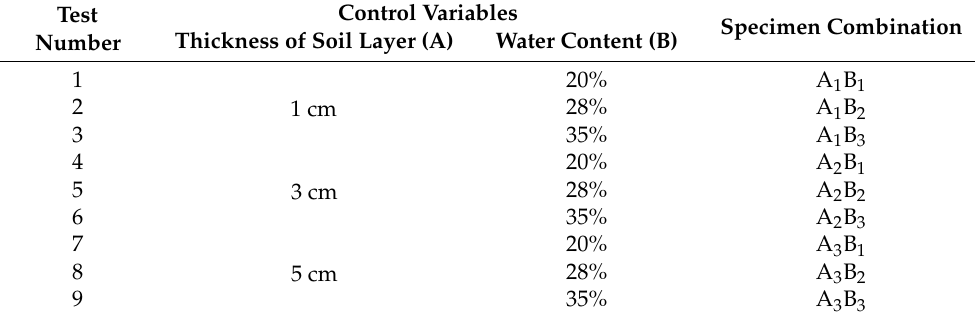
Table 2. Dry shrinkage test